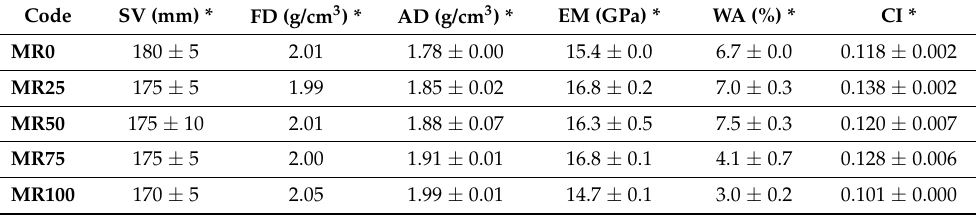
Table 6. The fresh and hardened properties of mortars produced with different dosages of local calcined clays at 28